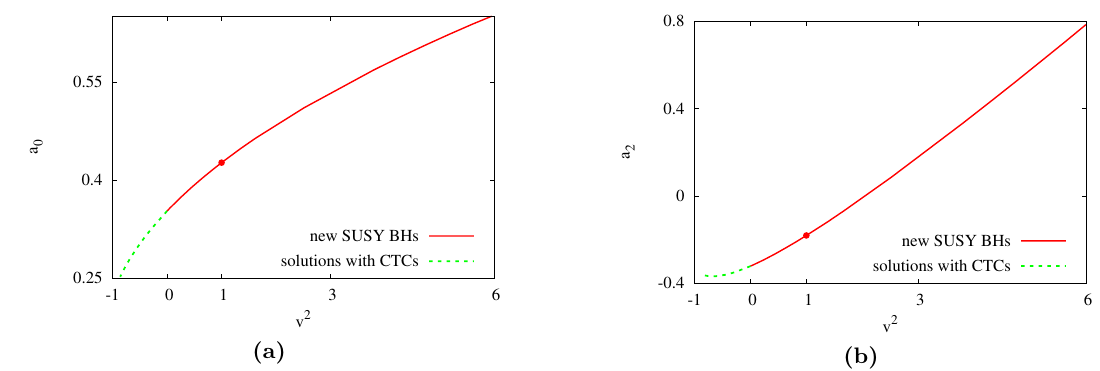
Figure 13. (a) The large- (cid:26) expansion parameter a 0 as a function of the squashing v . (b) The same for the parameter a 2 . Here and in (cid:12)gures 14 the red point marks the Gutowski-Reall solution from where the new susy black holes emerge, and the dashed green line the subset of solutions with closed timelike